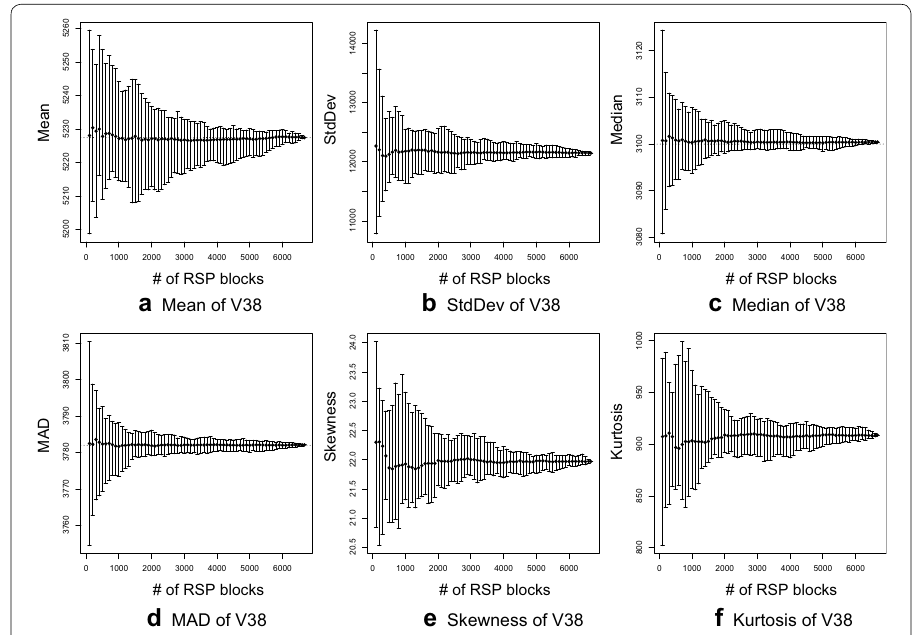
Fig. 8 Summary statistics of V38 in power. Incremental estimation of summary statistics of V38 using samples of RSP blocks of Power data ( g = 100 )